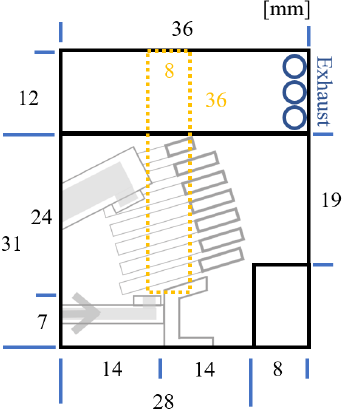
Figure 8. MCCB interior space and virtual space for hot gas movement (side view).